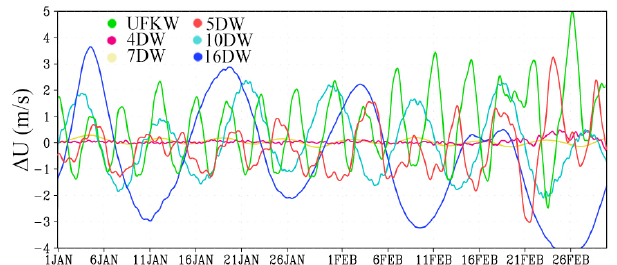
Figure 5. Time series of mean zonal wind variations due to the inclusion of tropospheric sources of various PWs in the regions of their maximum amplitudes in the